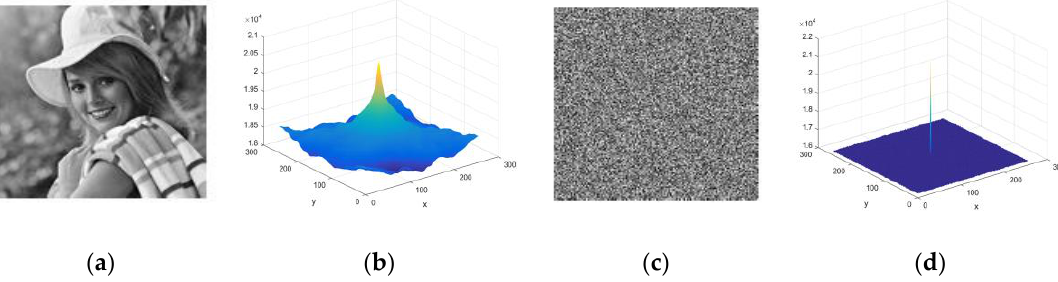
Figure 14. Image autocorrelation plots: ( a ) Original image; ( b ) Autocorrelation of original image; ( c ) Cipher image; ( d ) Autocorrelation of cipher image.